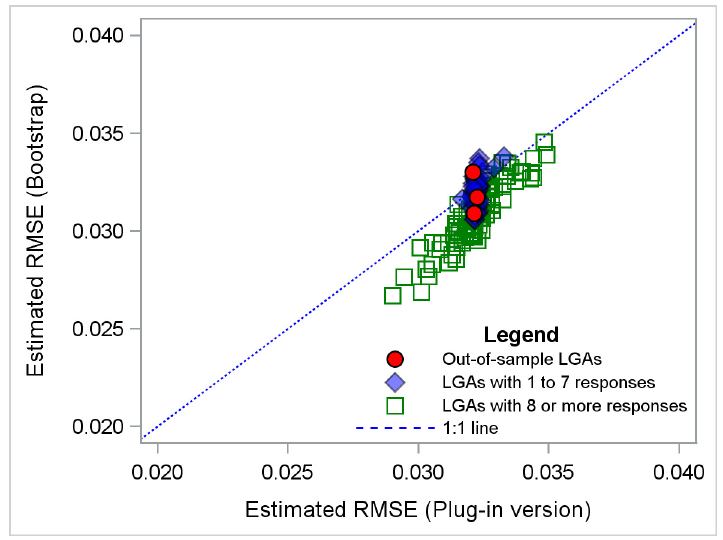
Figure 2. Bootstrap versus plug-in RMSEs for LGA-level EBLUP model-based estimates of proportion of smoking in males, 2006, using a linear mixed model. The model included age group, marital status, education level and private health status.